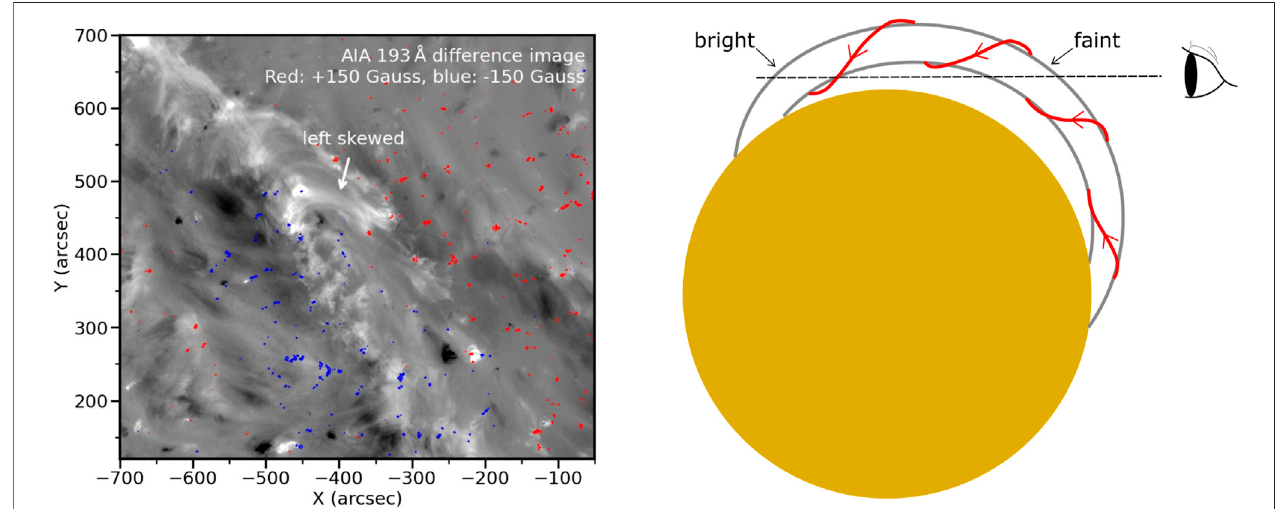
FIGURE8| Prominence chirality and view. (A) AIA193 (cid:1) A difference image bythe image observed at 16:00:06 UT subtracting the oneat 11:57:06UT. The red and blue contours mark LOS magnetic fi eld ± 150 Gauss, respectively, from HMI observed at 15:59:05 UT. (B) Cartoon showing the prominence viewing angle. The red arrows represent the magnetic helicity with exaggerated twist